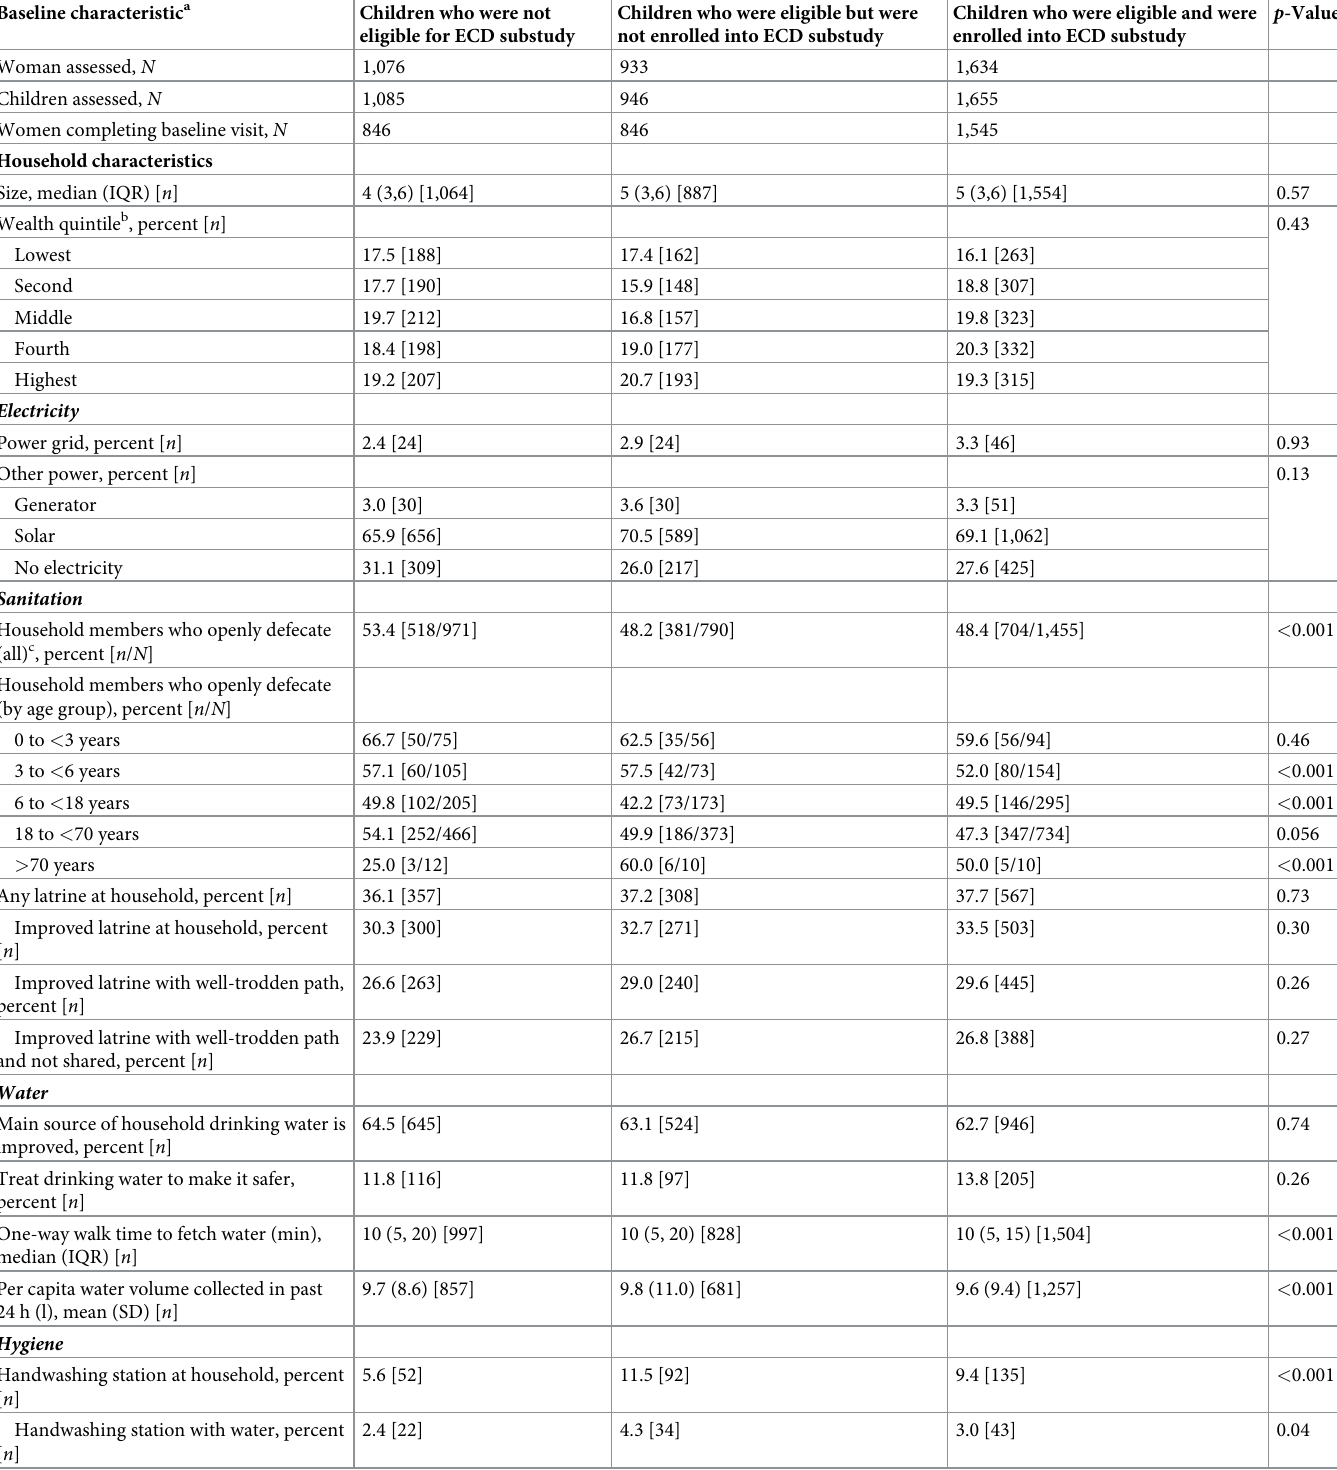
Table 1. Comparison of baseline characteristics across 3 groups of children: children who completed the 18-month visit but were not eligible for the ECD substudy, children who were eligible for but were not enrolled into the ECD substudy, and children who were eligible for and were enrolled into the ECD